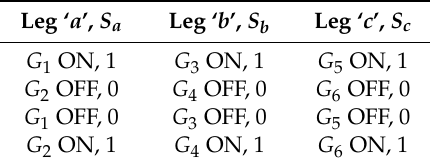
Figure 1. Power circuit of three-phase VSI with RL load. Table 1. Gating signals of the inverter power switches.